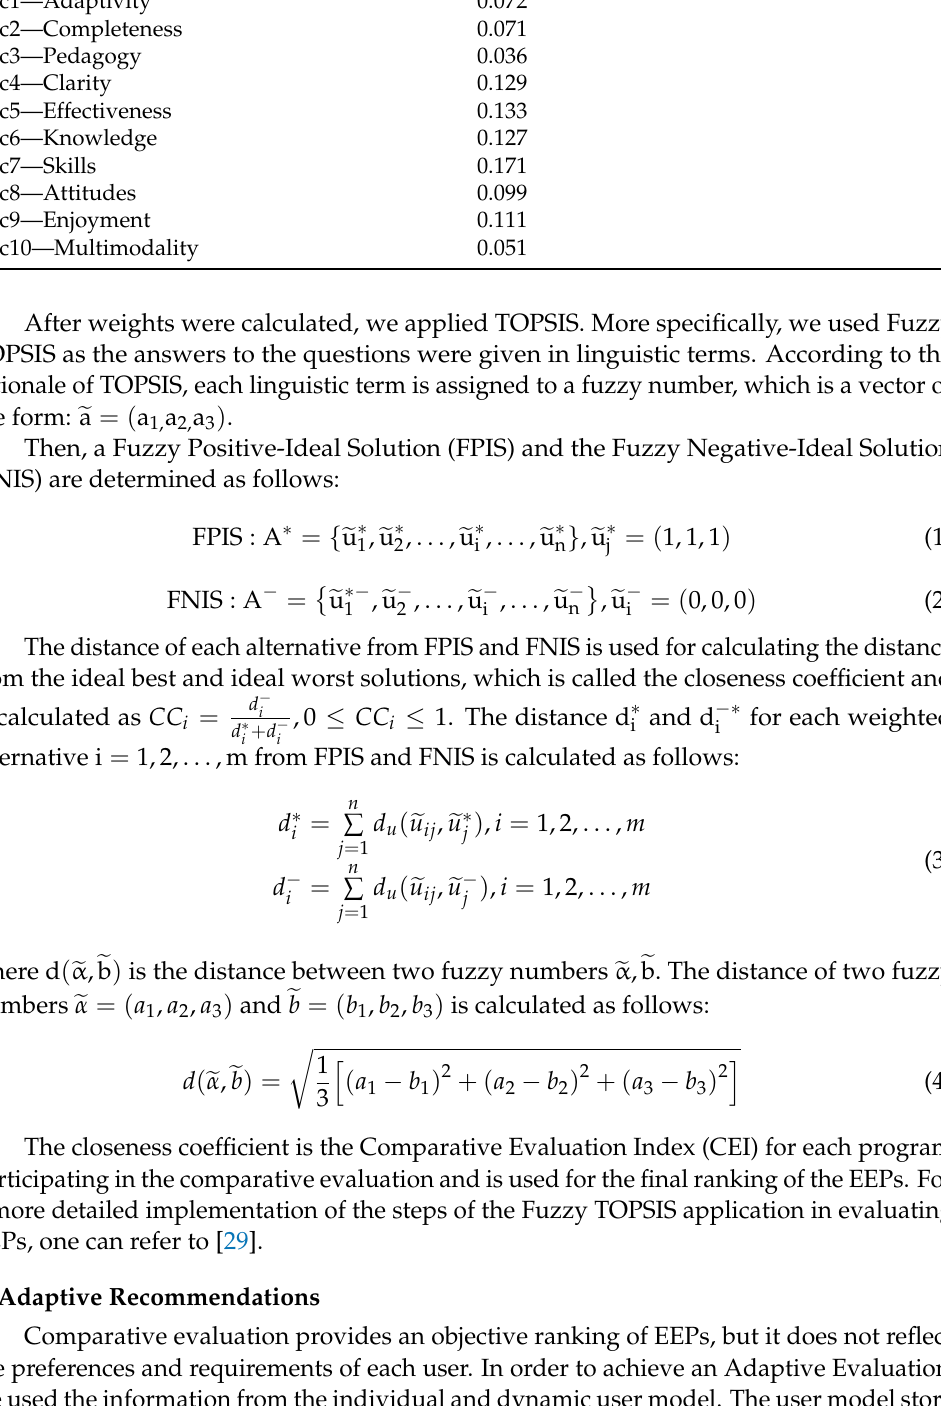
Table 2. The estimated weights of the comparative evaluation criteria [29].